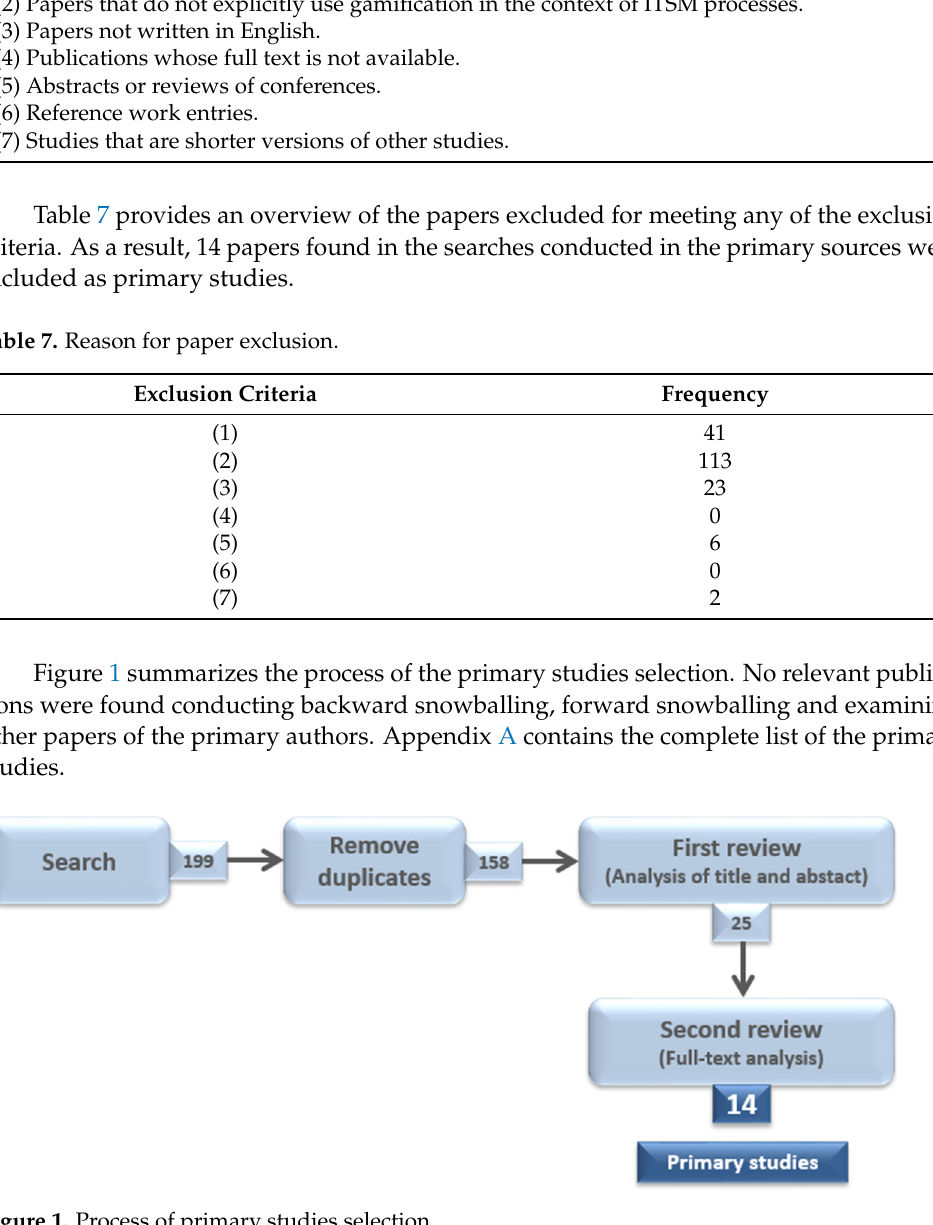
Figure 1. Process of primary studies selection